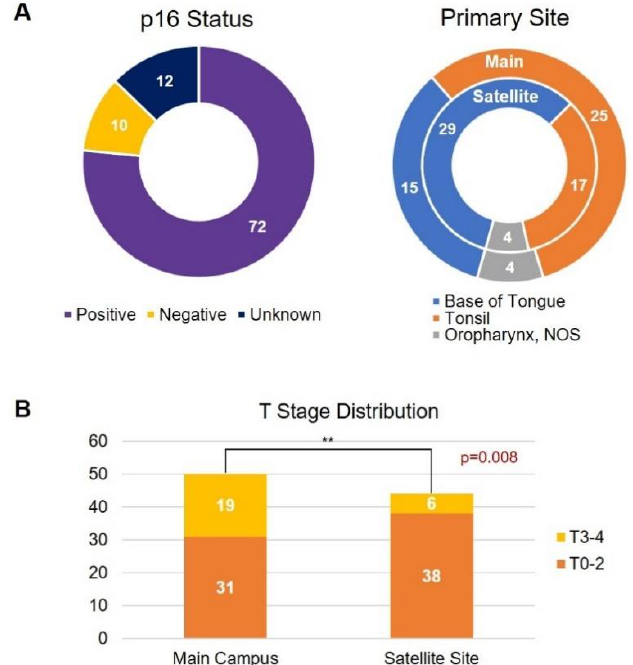
Figure 1. ( A ) P16 breakdown and oropharynx primary site breakdown in patient population and ( B ) T stage disease distribution by treatment site.